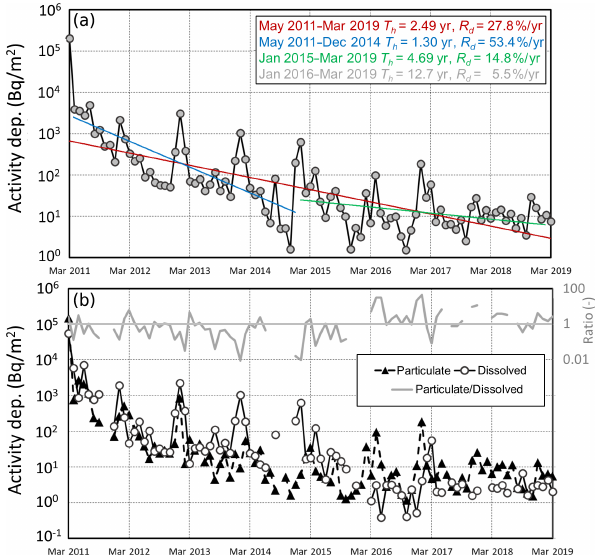
Figure 3. (a) Time series of 137 Cs activity deposition. The red, blue, and lime lines indicate the regression lines of the whole pe- riod, before 2015, and after 2015, respectively. The half-lives ( T h ) and decay rates ( R d ) are also depicted. As T h and R d values after 2016 are substantially different from those after 2015, the values are additionally depicted in gray. (b) Time series of the particulate and dissolved forms of 137 Cs deposition on the left axis and the ratio of particulate to dissolved 137 Cs on the right axis.